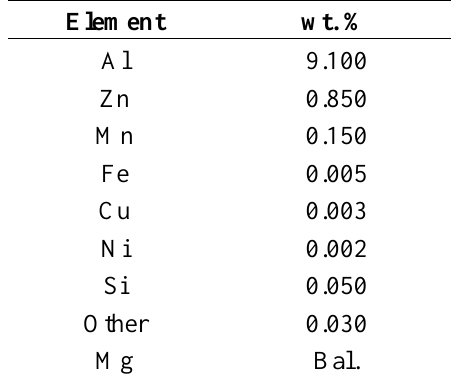
Table 1. Composition of the AZ91D Mg alloy used in this work, obtained by optical emission